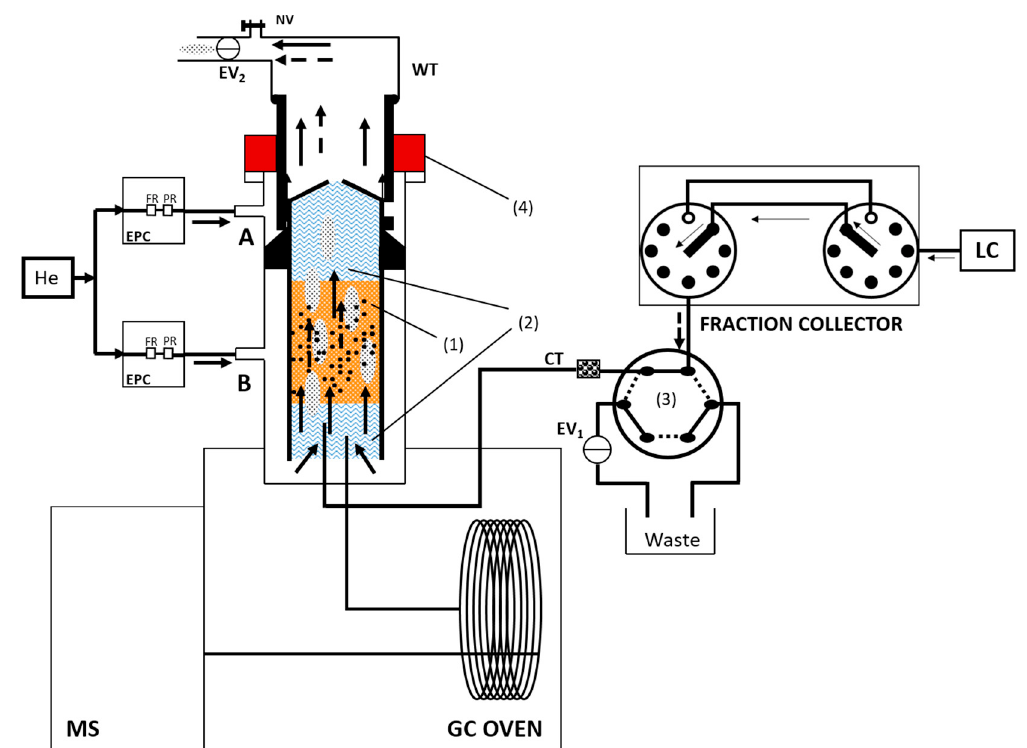
Figure 2. Scheme of the TOTAD interface with fraction collector during the transfer step. Symbols: (1) sorbent (Tenax TA); (2) glass wool; (3) six-port valve; (4) heated cover; (EV1 and EV2) electro-valves 1 and 2; (EPC) electronic pressure control; (PR) pressure regulator; (FR) flow regulator; (solid arrows) gas flow; (dotted arrows) liquid flow; (CT) silica capillary tubing, 0.32 mm i.d.; (WT) waste tubing; (W) waste; ( ) solvent; ( ) analytes; (NV) needle valve.